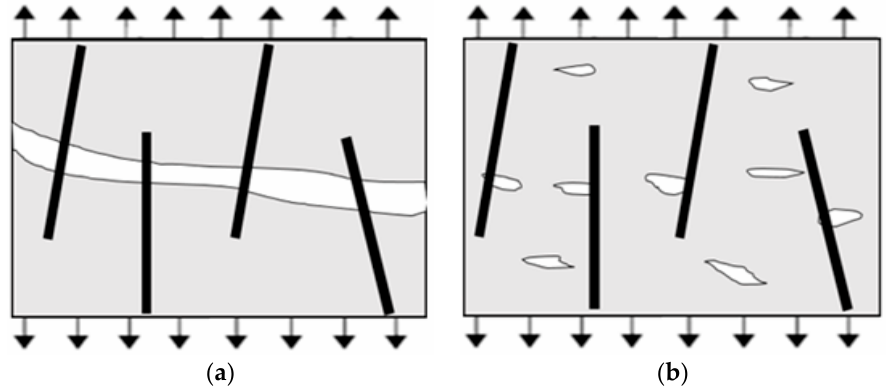
Figure 12. Mechanism of long-fiber reinforcement: ( a ) concrete with macrocracks and ( b ) concrete with microcracks.